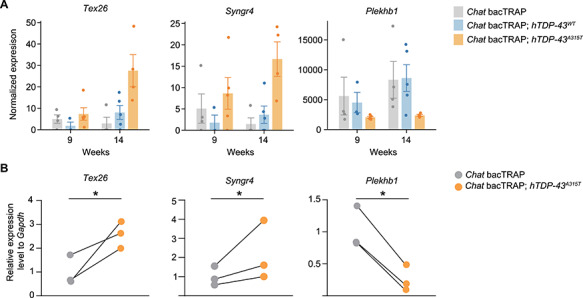

Tex26, Syngr4 and Plekhb1 mRNAs are deregulated in the hTDP-43A315T MN translatome at motor symptom onset. (A) RNA-Seq results for Tex26, Syngr4, and Plekhb1 are shown at pre-symptomatic and early symptomatic stages (9 and 14 weeks, respectively). Gene expression levels are normalized to the sequencing library size. Mean values ± SEM are shown. (B) Corresponding qRT-PCR validation for Tex26, Syngr4, and Plekhb1 mRNAs at 14 weeks. The qRT-PCR validation experiments are MN-TRAP assays from an independent cohort Chat bacTRAP; hTDP-43A315T and Chat bacTRAP control mice. Average relative expression values normalized to Gapdh mRNA levels are shown. n = 3 for qRT-PCR experiments; values for each genotype from each specific experiment are shown; corresponding genotype pairs from a specific replicate are linked by black lines; paired t-test; *P < 0.05.